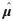
Correlation between median μ^ for a discipline and the discipline’s relative size.We use Rosvall et al. [28] reported values of the relative number of citations to publications in journals of several disciplines as a proxy for relative field size and compare them with the median value of μ^ in each discipline. A Kendall rank-correlation test yields a τ
K = 0.62 with p = 0.069. This correlation suggests that μ^ depends on the typical number of citations of a discipline.